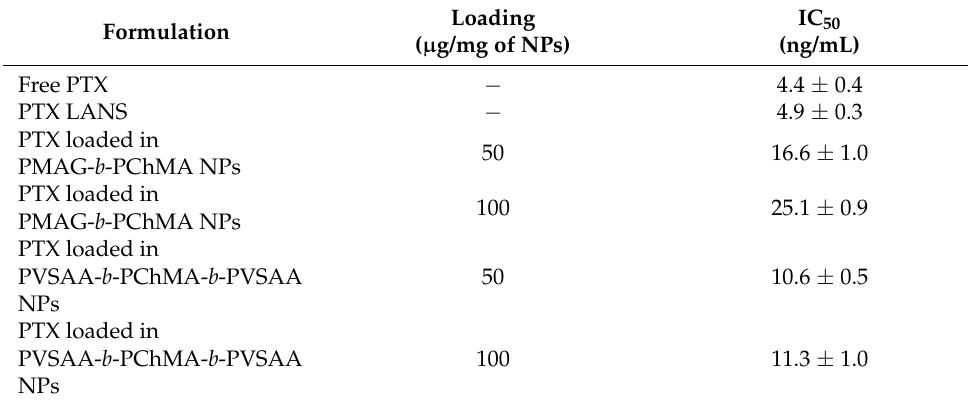
Table 3. IC 50 values determined on A549 cells for the free PTX, Paclitaxel LANS ® , and developed PTX formulations.